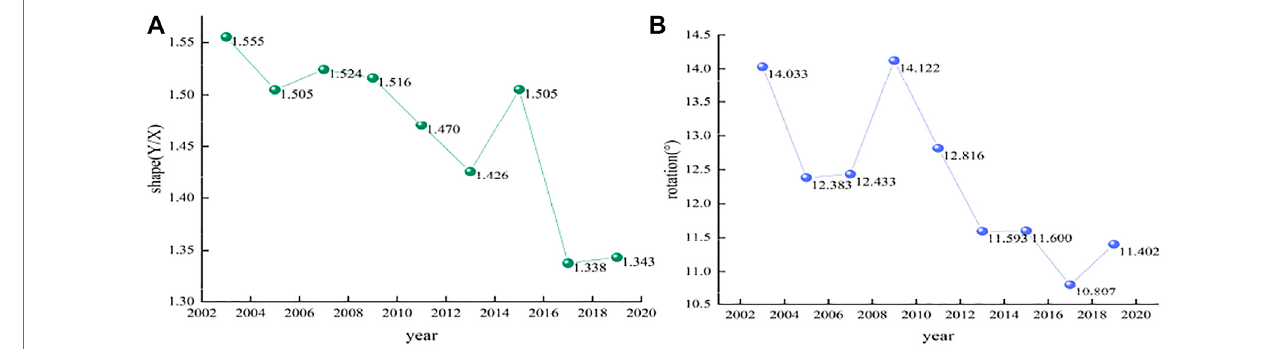
FIGURE 5 | Change of the rotation and shape of carbon emission in China from 2003 to 2019.